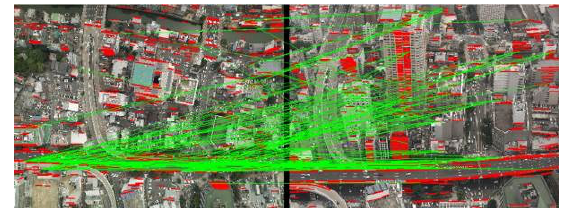
Figure 17. Matching result (color information)